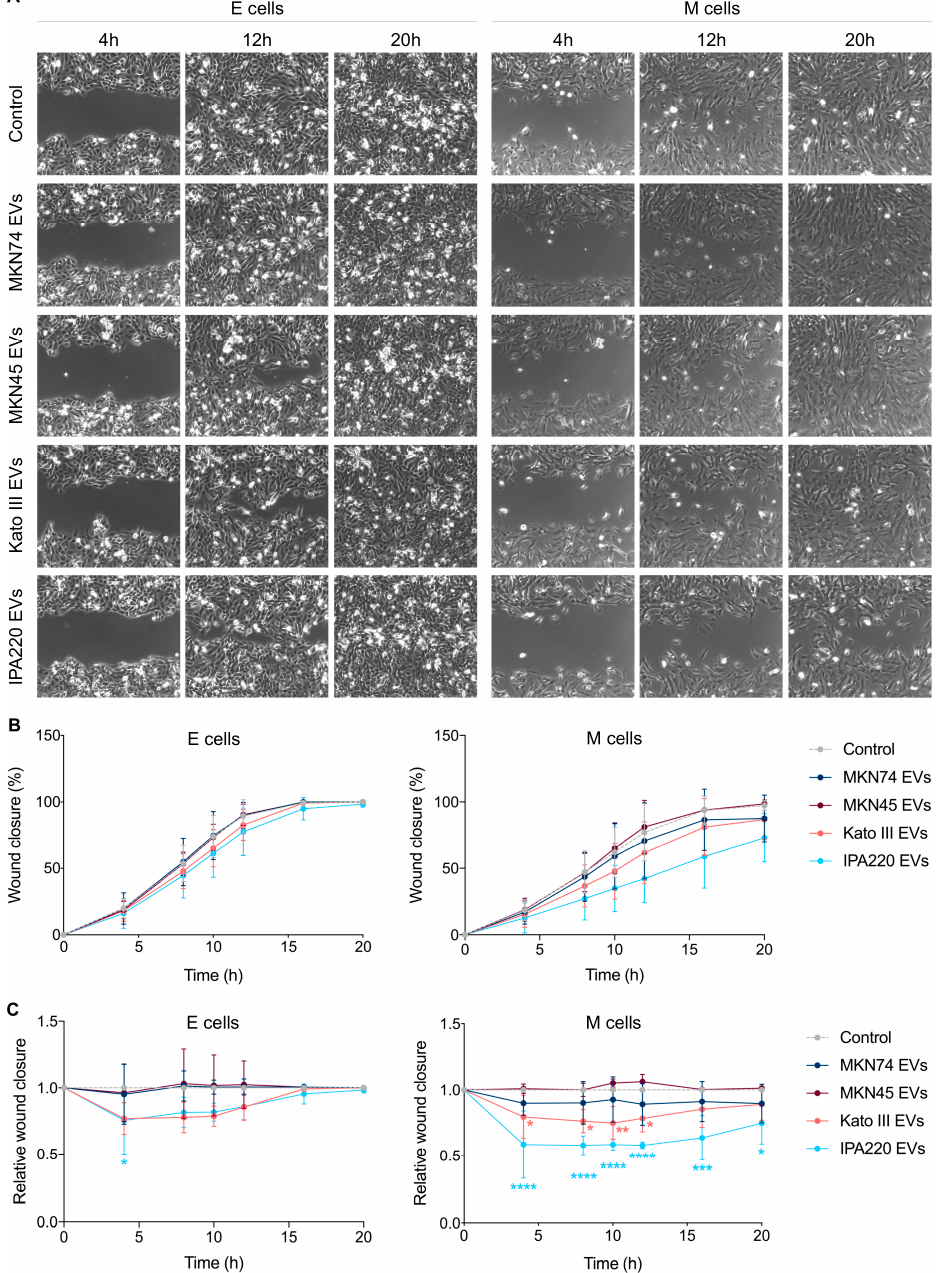
Figure 5. GC-EVs impair the migration of epithelial and mesenchymal cells. ( A ) Time-lapse microscopic images illustrating the migration of non-treated (control) and treated epithelial and mesenchymal cells, at distinct time-points; ( B , C ) the migration rate of non-treated (control) and treated epithelial and mesenchymal cells was assessed by time-lapse microscopy; ( B ) graphs represent the mean percentage of wound closure ± standard deviation of three independent experiments; ( C ) graphs represent the mean of normalized wound closure ± standard deviation of three independent experiments; the data was normalized to the control cells at each time-point (* p ≤ 0.05, ** p ≤ 0.01, *** p ≤ 0.001, **** p ≤ 0.0001, and two-way ANOVA with Dunnett’s multiple comparisons test; blue and orange asterisks correspond to E and M cells treated with IPA220-EVs or Kato III-EVs,